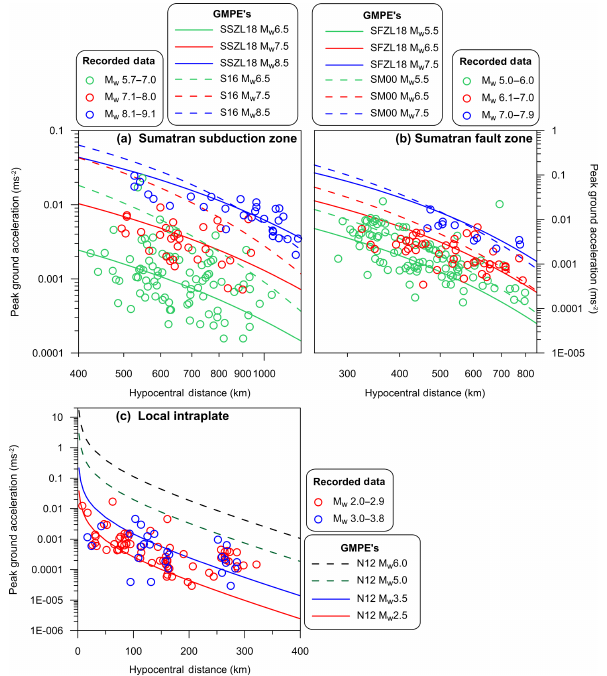
Figure 7. Plots at various magnitude intervals for the GMPEs used in the current study with respect to recorded ground mo- tion data for the (a) Sumatran subduction zone, using GMPEs proposed by Loi (2018) and Shoushtari et al. (2016), denoted as SSZL18 and S16, respectively; the (b) Sumatran fault zone, us- ing the GMPEs proposed by Loi et al. (2018) and Si and Mi- dorikawa (2000), denoted as SFZL18 and SM00, respectively; and the (c) local intraplate fault zone, using the GMPE proposed by Nguyen et al. (2012), denoted as N12.